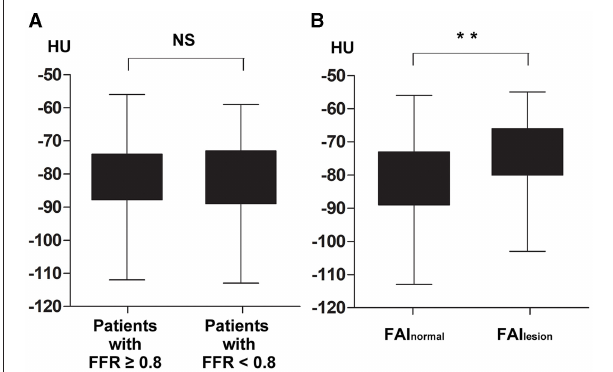
FIGURE 2 | Comparisons of lesion-free fat attenuation index (FAI normal ) in different kinds of patients and intra-patient comparison of FAI according to atherosclerosis status. There was no difference in FAI normal between patients with and without functional ischemia, − 82 ± 11 HU vs. − 81 ± 11 HU, p = 0.65 (A) ; FAI lesion was significantly higher than FAI normal with intra-patient analysis, 74 ± 9 HU vs. − 81 ± 10 HU, p < 0.01 (B) . FAI normal , lesion-free fat attenuation index; FAI lesion , lesion-specific fat attenuation index; FFR, fractional flow reserve; HU, Hounsfield unit; NS, non-statistical significance. ** p < 0.01.